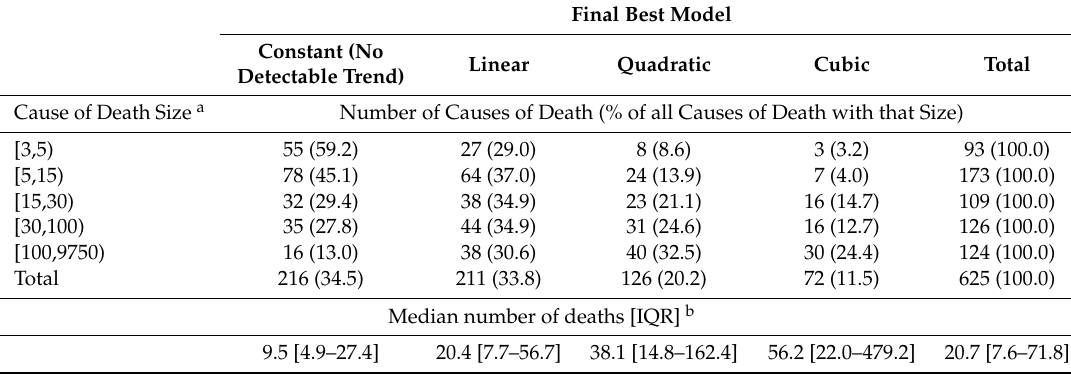
Table 1. Distribution of the Causes of Death (ICD-10 three-position), according to the final best model, stratified by their size.